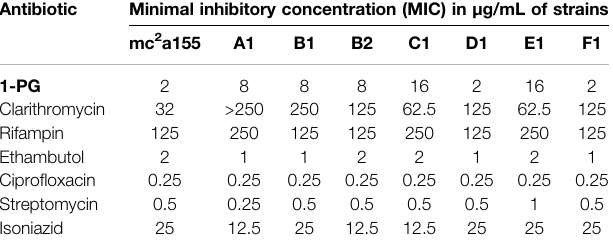
TABLE 1 | MICs of Standard Mycobacterial Drugs Against 1-PG-resistant Mutants of Mycobacterium smegmatis strain mc 2 155. The bold values are short form name of the antimycobacterial compound in Figure 1 , 1-PG. Antibiotic Minimal inhibitory concentration (MIC) in µg/mL of strains